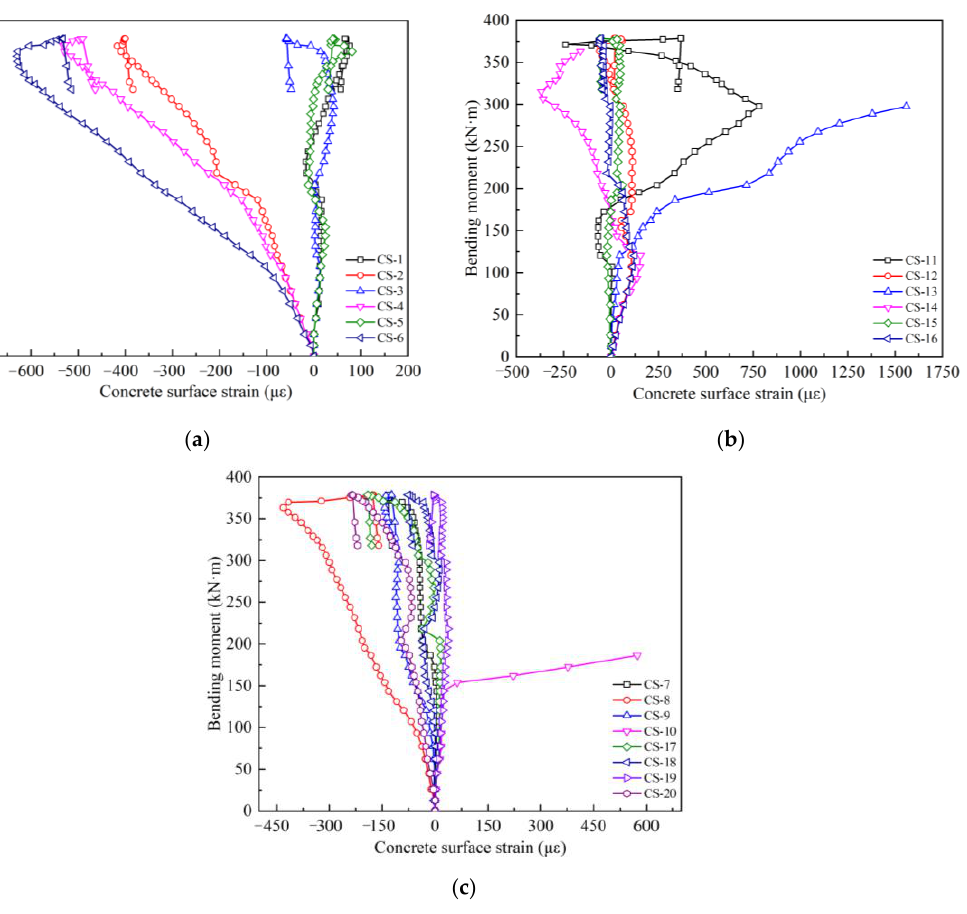
Figure 14. The bending moment – concrete strain relationship curves of 1/4 section: ( a ) monitoring points on top surface, ( b ) monitoring points on the bottom surface, ( c ) monitoring points on front and back surfaces.